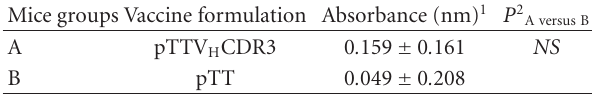
Table 1: Reactivity of mouse sera against a CDR3 control (irrelevant) peptide as assessed by